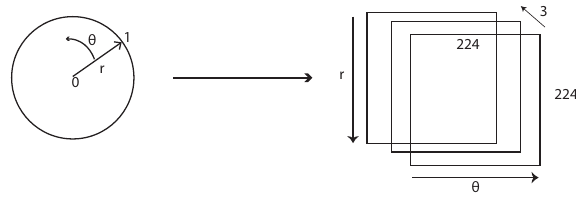
Figure 6. Our adopted technique for iris normalization.